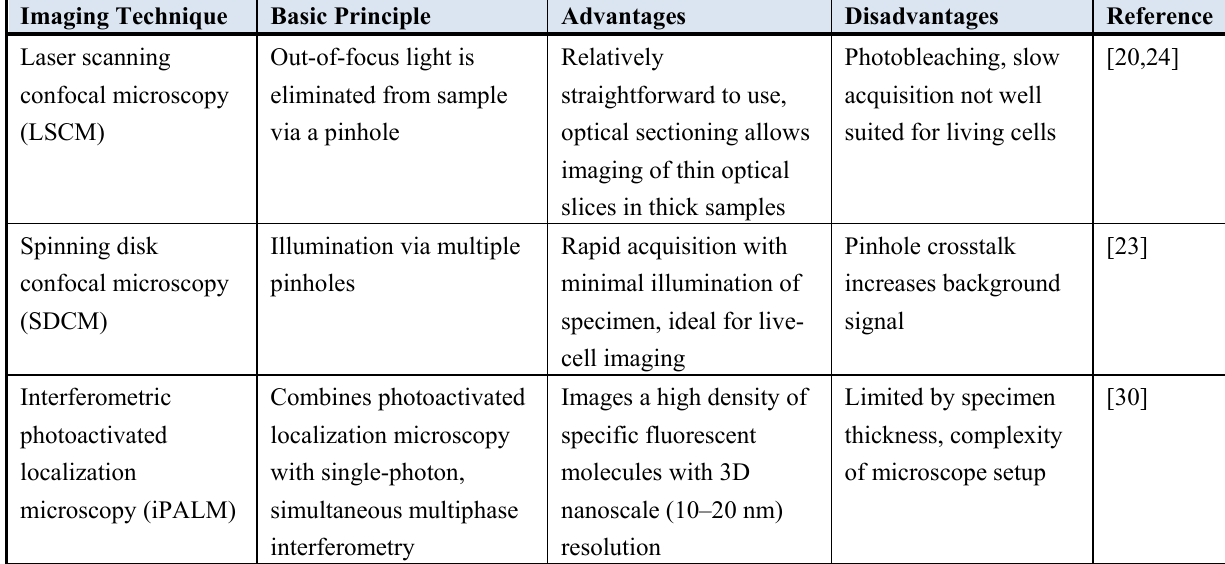
Table 1. Examples of imaging techniques used to visualize and analyze the cytoskeleton and focal adhesions in